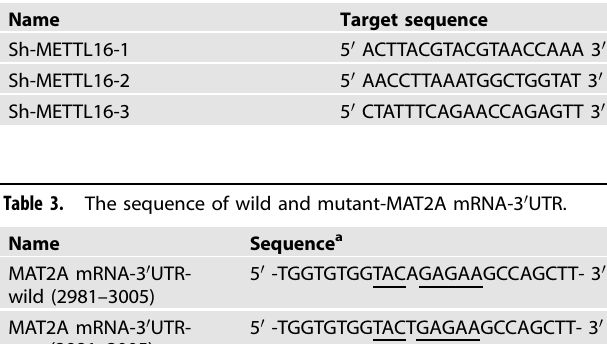
Table 2. The target sequence of short hairpin RNAs (shRNAs).